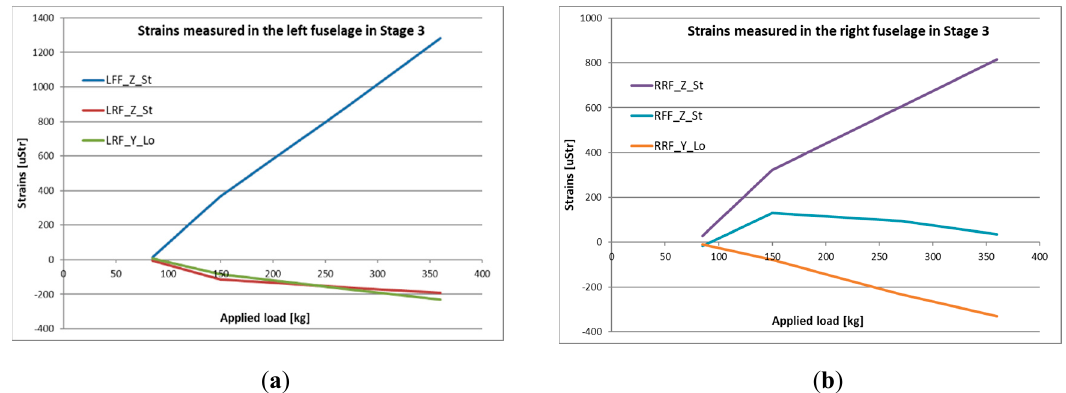
Figure 20. Strain measured in the ( a ) left and ( b ) right side of the fuselage during Stage 3.